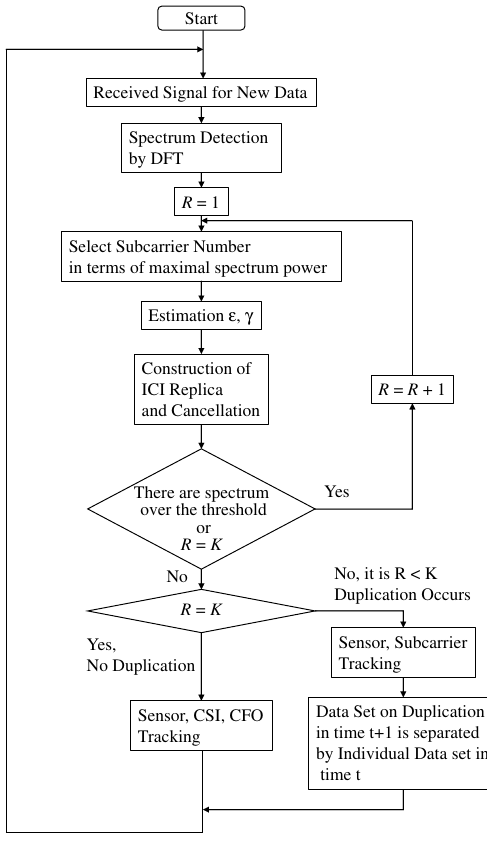
Figure 2. Flow chart of proposed ICI cancellation and data